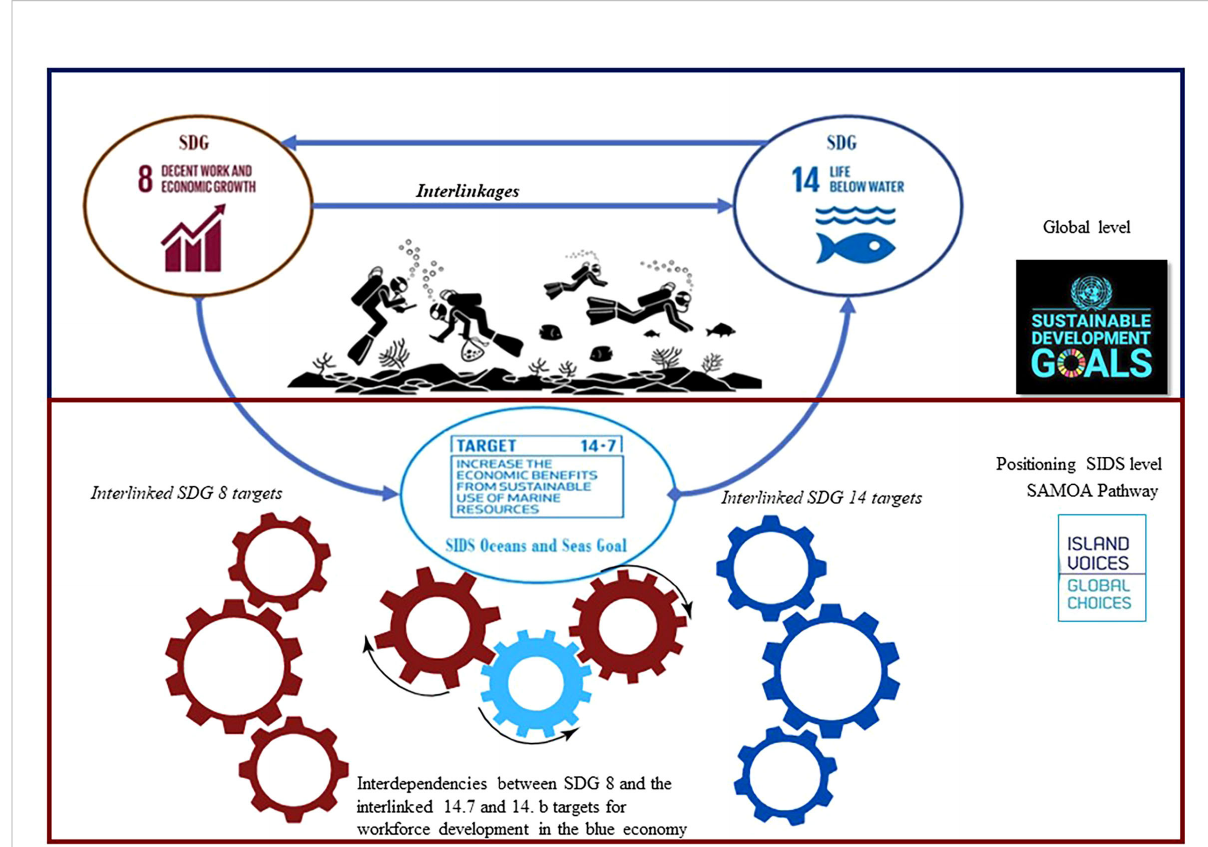
FIGURE 1 Three-tier level sustainable development goal interlinkages for decision-makers at the global, small island developing states (SIDS), and island government levels for dive fi sher workforce development in the blue economy. The SIDS level via the SIDS Accelerated Modalities of Action pathway demonstrates their policy priority and interdependencies between ILO SDG 8 targets, 14.7 and 14.b. Expanded from Nisa et al. (2022) via systems thinking and systems integration advocated by Liu et al.